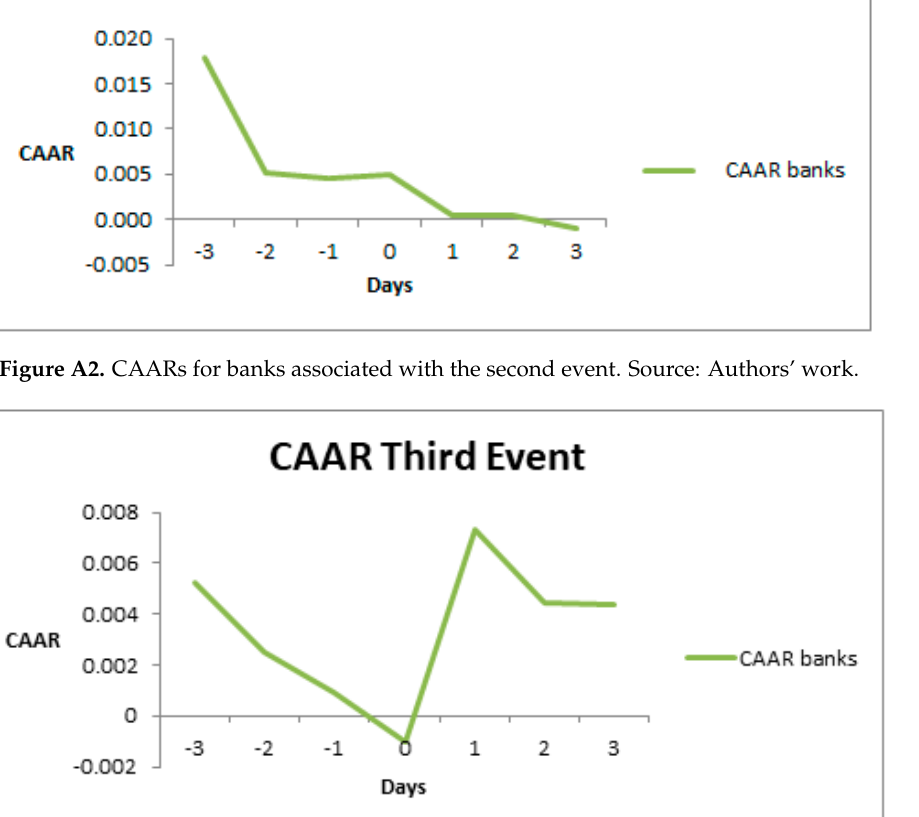
Figure A3. C AARs for banks with the third event. Source: Authors’ work.